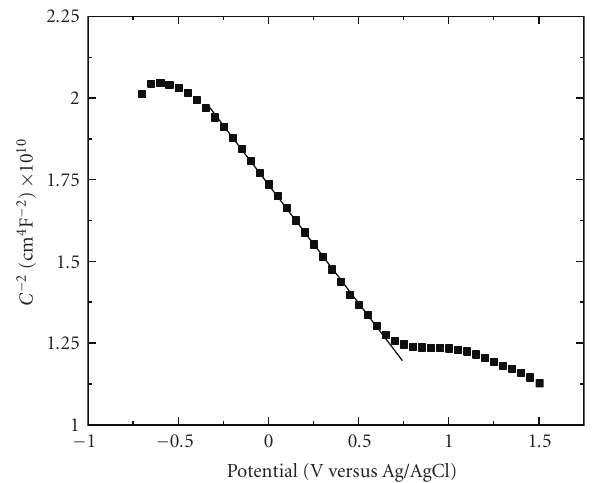
Figure 10: Room temperature Mott-Schottky plot C − 2 versus the potential in 0.5molL − 1 H 2 SO 4 obtained at 1000 Hz for as-grown BDND